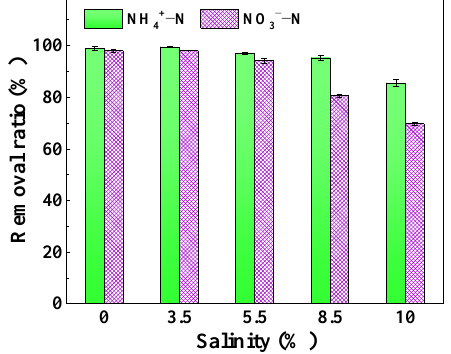
Figure 9. Influence of salinity on nitrogen compounds removal on Vibrio sp. LY1024.